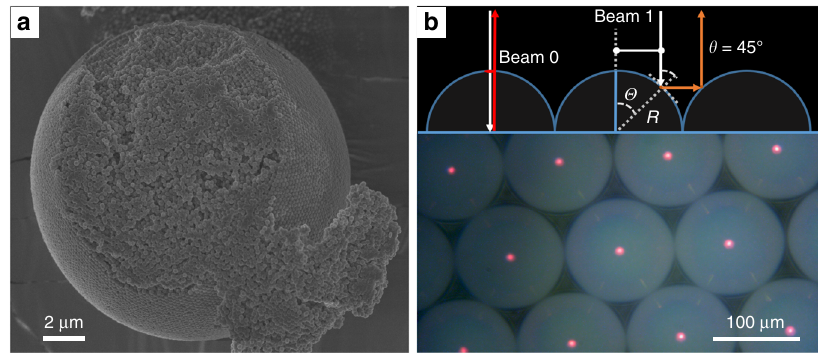
Fig. 4 SEM image of a supersphere and Bragg re fl ection of it. a Scanning electron micrograph of a dried supersphere formed from a raspberry dispersion in a micro fl uidic device as described in Fig. 3. b The top image describes the different optical effects produced by densely packed superspheres as observed under the microscope. The red centre spots are caused by specular re fl ection of non-propagating wavelengths, and the streaks of light are seen where the superspheres touch each other and light is re fl ected straight back into the microscope. The bottom image is a micrograph obtained in epi-illumination of the superspheres using as small numerical aperture for the illumination (NA = 0.1)